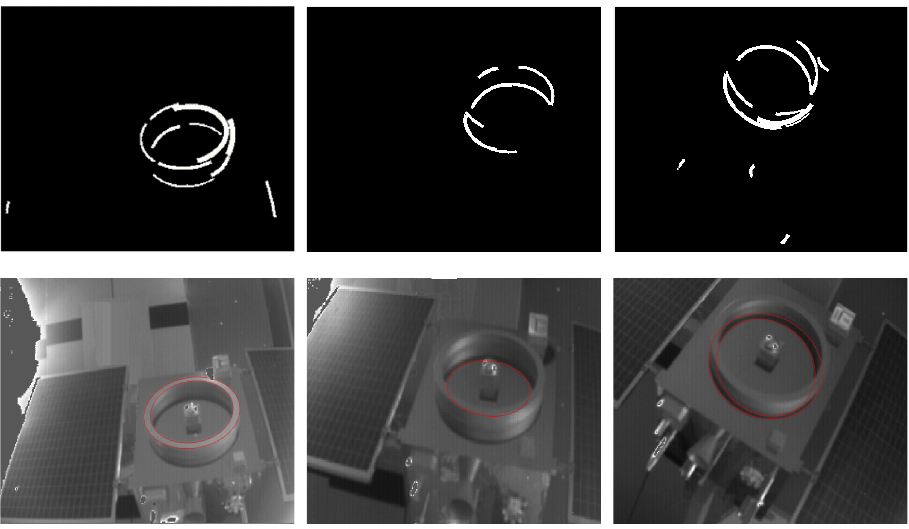
Figure 1. Different types of ellipse-detection